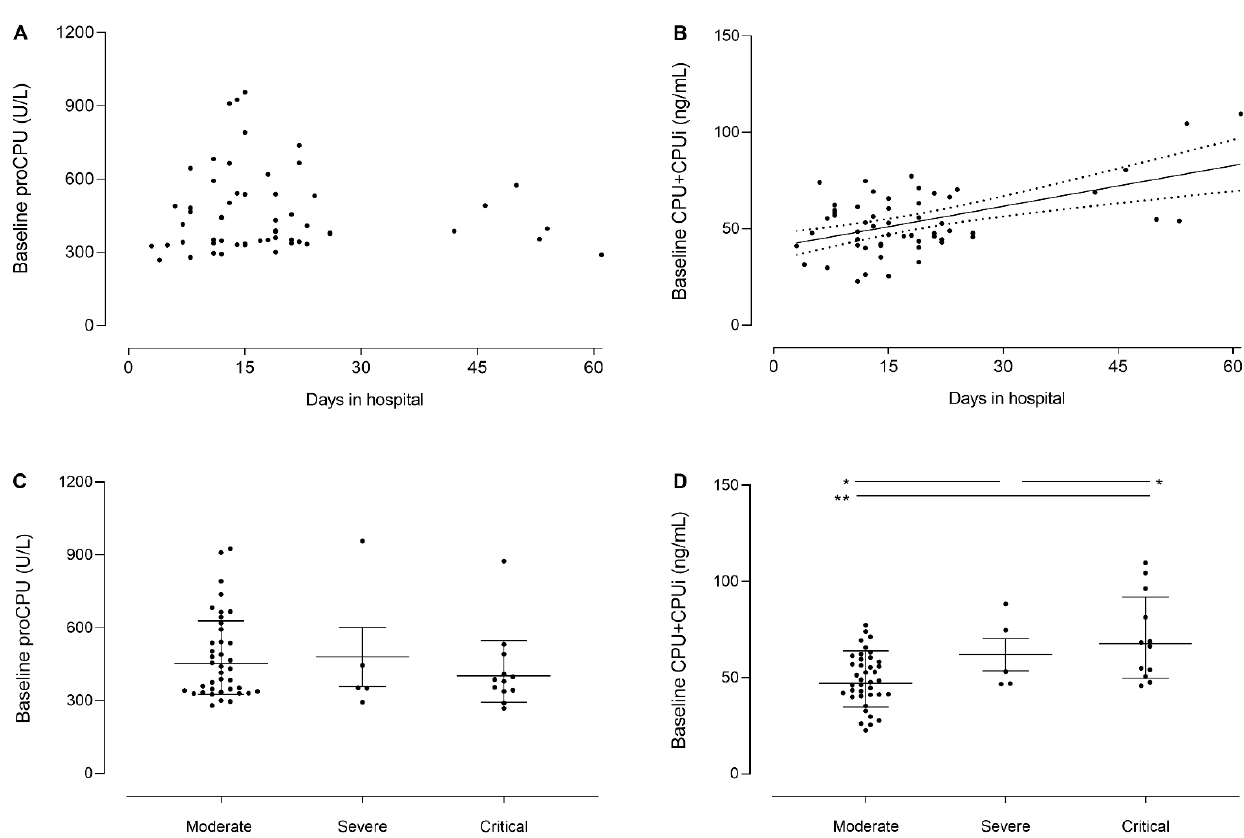
Figure 4. Correlation between the duration of hospitalization and both baseline (inclusion time point shortly after hospital admission) procarboxypeptidase U (proCPU) ( A ) and total active and inactivated carboxypeptidase U (CPU+CPUi) antigen levels ( B ) in hospitalized COVID-19 patients (N = 56). Spearman correlation coefficient r was determined. For statistically significant correlations ( p < 0.05), linear regression analysis was performed and the best-fit line (solid line) with 95% confidence bands was plotted (dashed lines). Baseline proCPU levels ( C ) and baseline CPU+CPUi antigen levels ( D ) of hospitalized COVID-19 patients grouped by disease severity (WHO COVID-19 disease severity categorization): moderate (N = 39), severe (N = 5), and critical (N = 12). Mann–Whitney U test (unpaired data); * p < 0.05; ** p < 0.01.